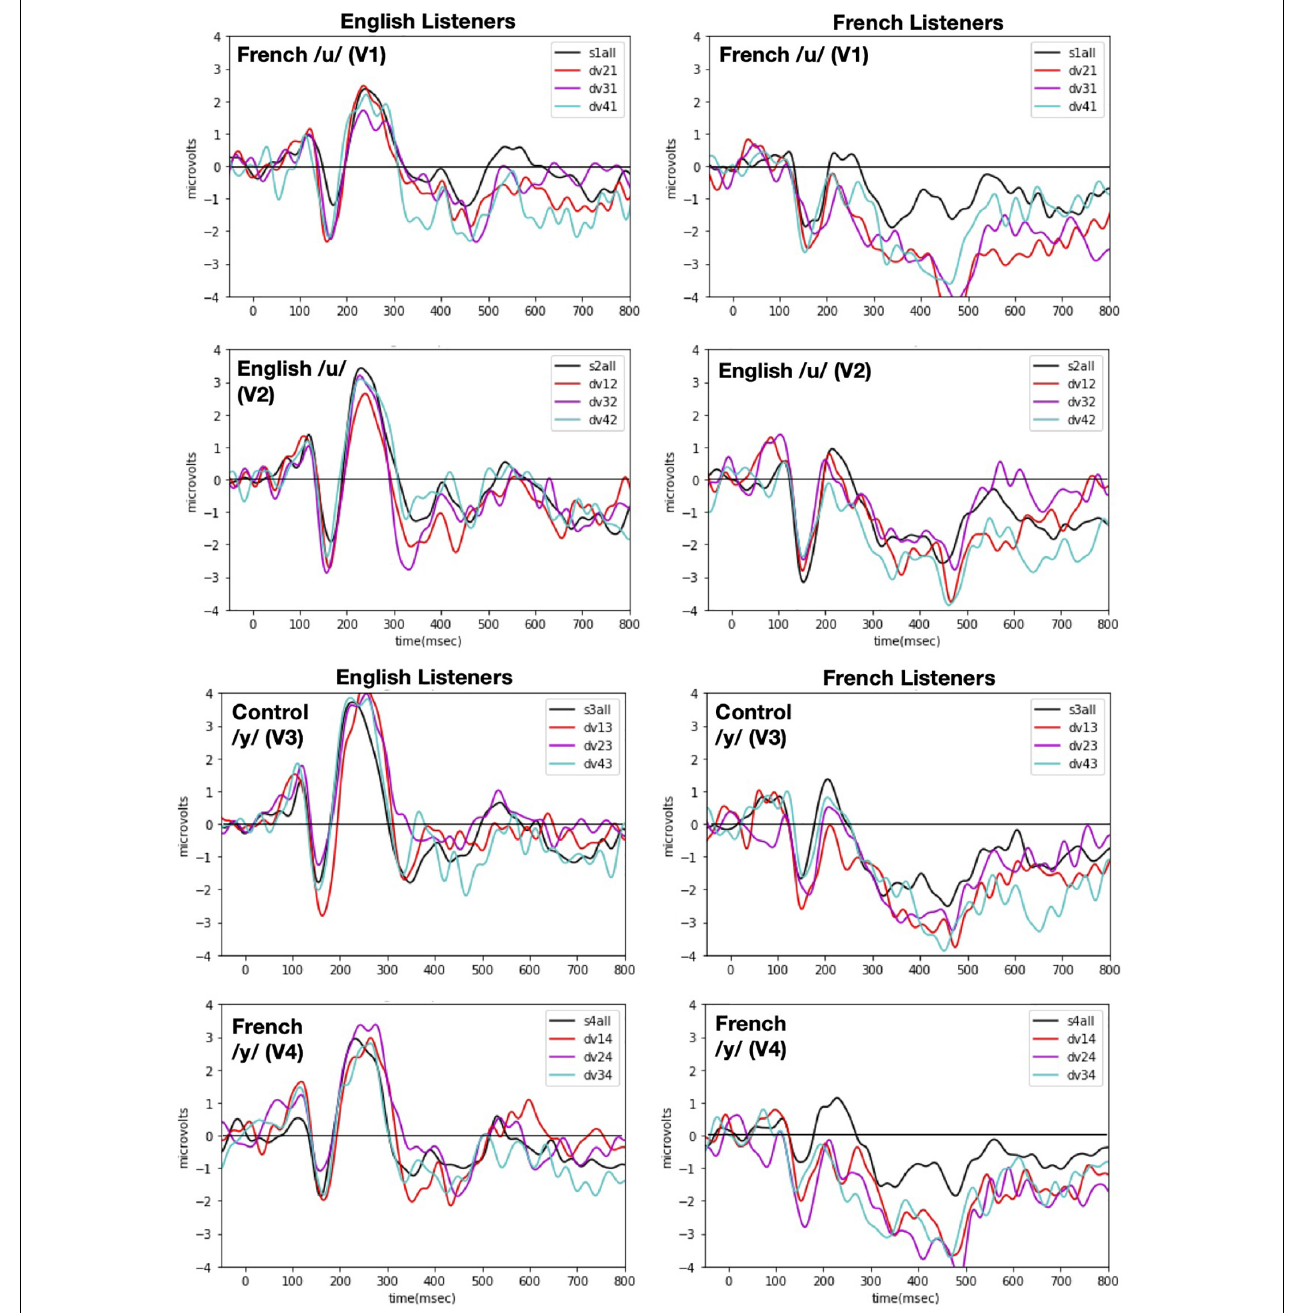
FIGURE 4 | ERP responses recorded with each of the four vowel tokens as the standard (V1, V2, V3, and V4 from top panel to bottom panel) and for each language group (English Listeners: left panels and French Listeners: right panels ). Each panel shows ERP responses recorded when one vowel (indicated in the left hand corner) was presented as the standard with each of the other vowels as the deviant. As indicated in the right hand corner, the deviants are plotted as different color lines and as a black line when all deviants are combined. Note: in labeling the waves, the first number designates the deviant vowel and the second number designates the standard, e.g., for dv21 and V2 is the deviant when V1 is the